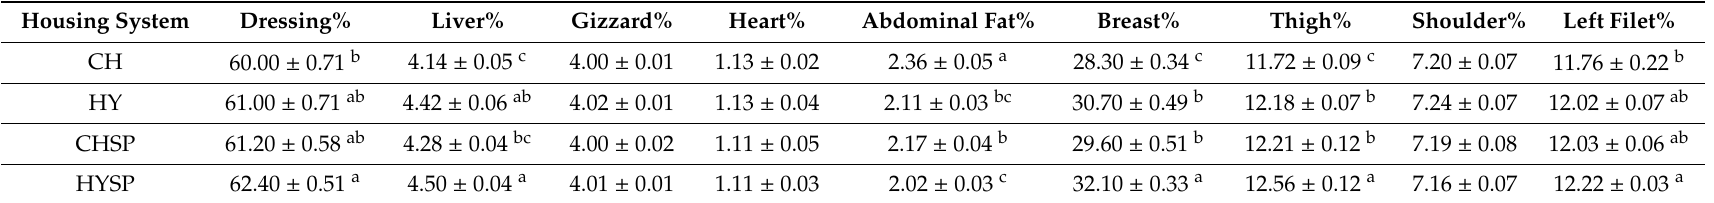
Table 2. E ff ect of di ff erent housing systems on carcass traits percentages of Pekin ducks.